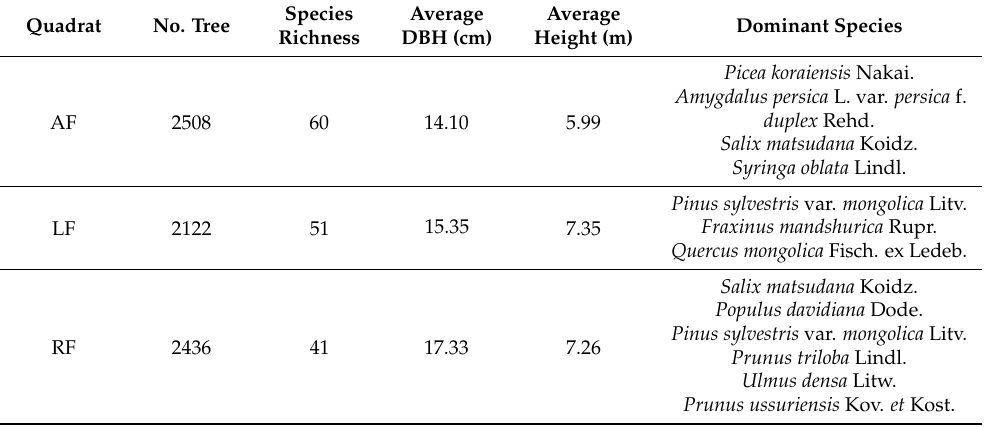
Table 1. Species distribution of different forest